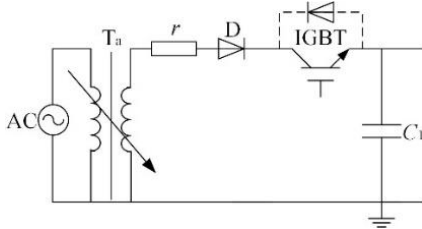
Figure 13. Diagram of the charging circuit. AC: alternating current.